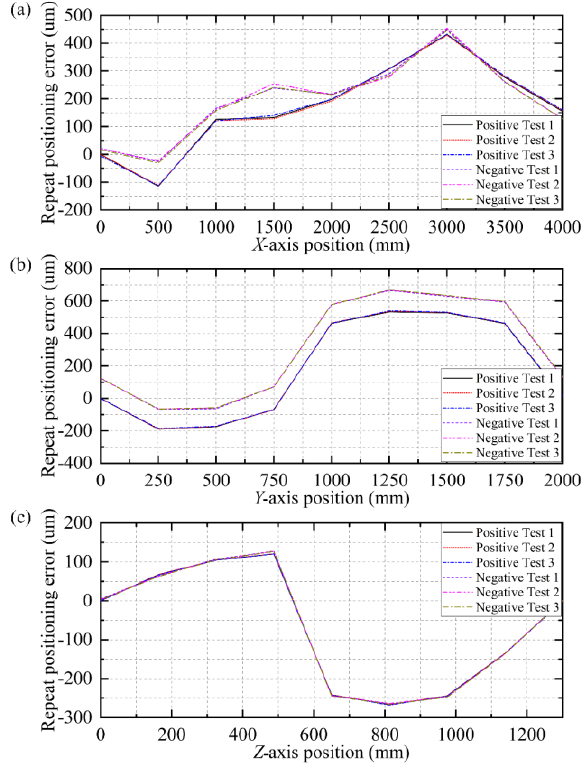
Figure 15. Repeat-positioning-error test results: ( a ) X -axis, ( b ) Y -axis, ( c ) Z -axis. According to the specified test method of repeating the measurement of the U- axis